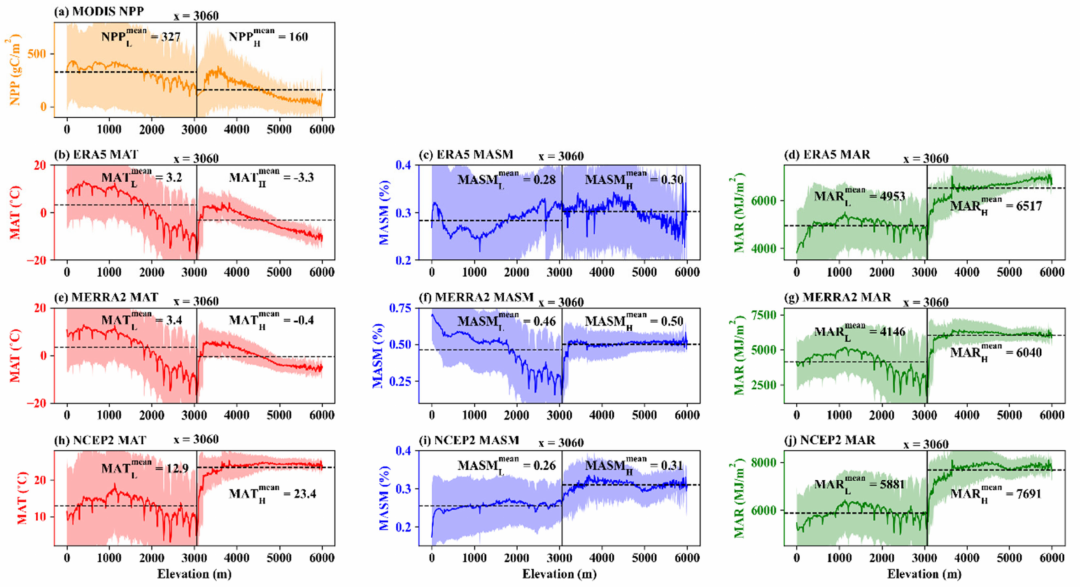
Figure A1. Changes in NPP and environmental factors along EG from 2001 to 2020. The elevation of 3060 m is used to distinguish high and low elevation (the vertical black solid line in Figure ( a – j )). The dashed line represents the average value of the variables at high and low elevations. The shaded areas with different colors in each figure represent ± 1